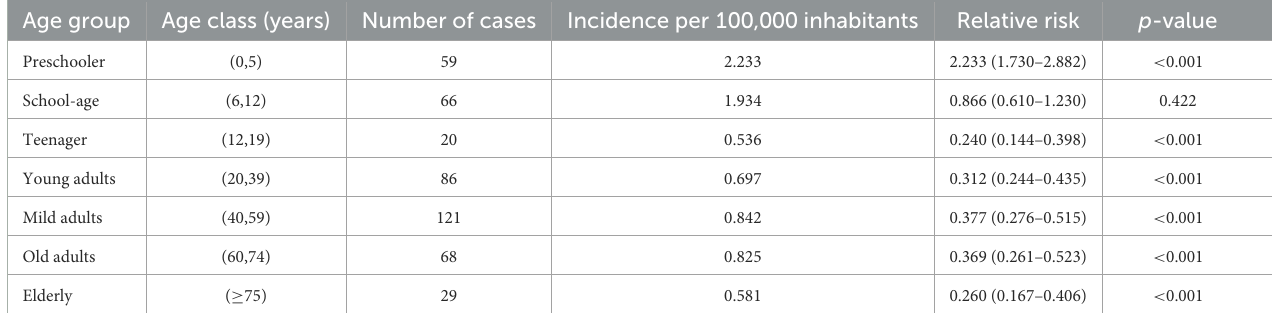
TABLE 1 Number of hospitalization cases and incidence per 100,000 inhabitants in Sicily between 2012 and 2021 per age class.